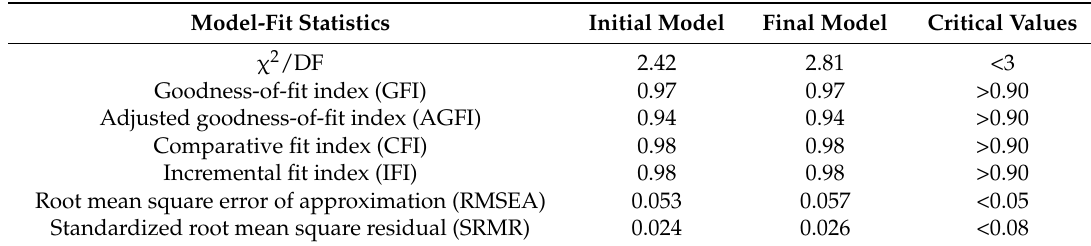
Table 3. The goodness-of-fit